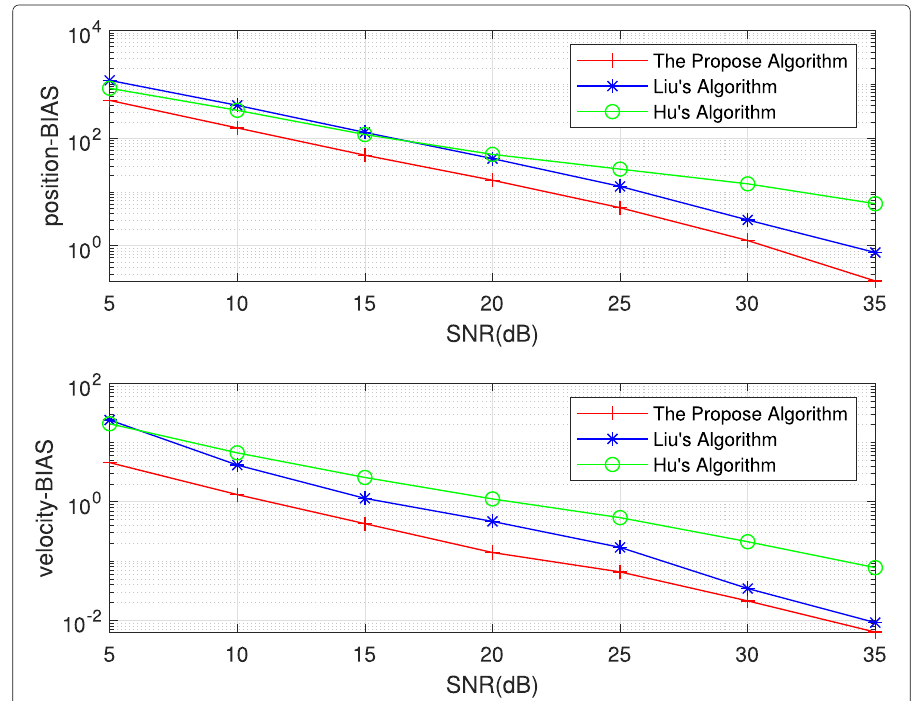
Fig. 4 Bias comparison of three algorithms for the far field